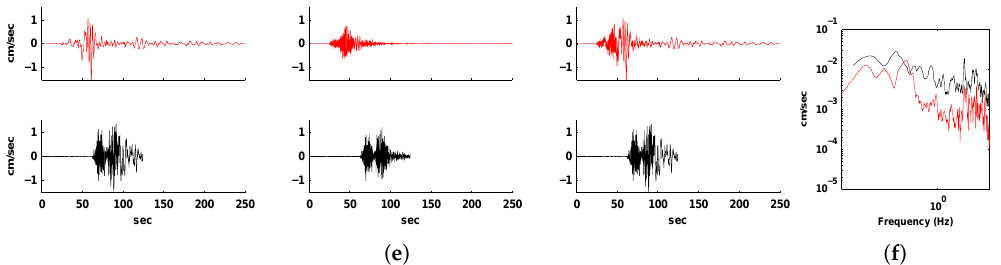
Figure 7. ( a ) North-south component, ( c ) east-west component, and ( e ) vertical component of ground velocity histories at Station 15. Shown in red are the long-period spectral-element-simulated (column 1), high-frequency EGF-synthesized (column 2), and combined broadband histories (column 3) for the 1999 Hector Mine earthquake. Shown in black are the corresponding filtered observed ground velocity records for comparison. ( b , d , f ) show the comparison of the corresponding spectra of the broadband velocity histories (red: synthesized, black: observed).